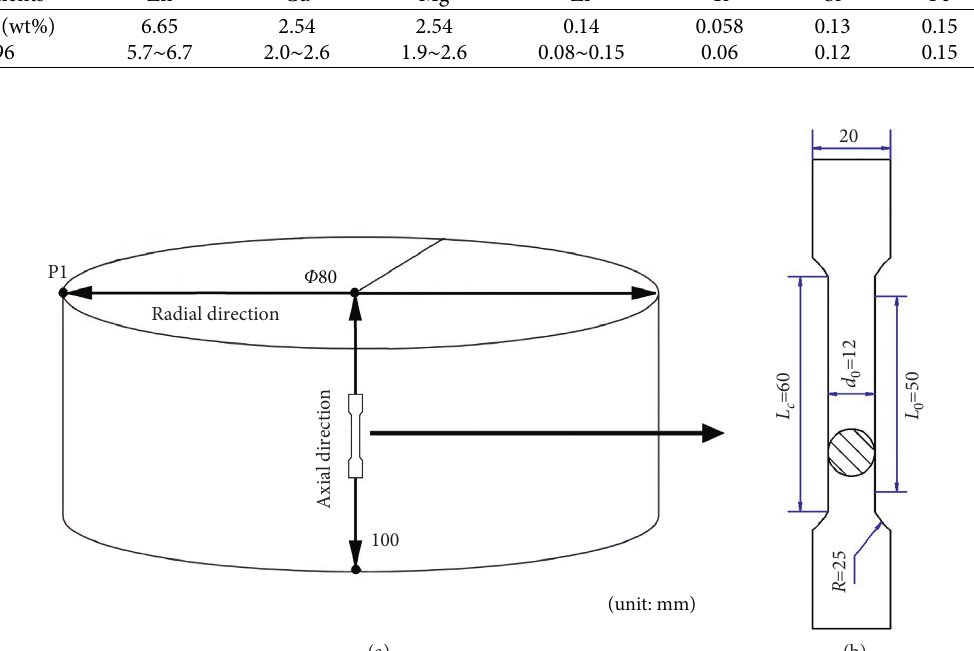
Figure 1: The sampling position (a) and the size diagram (b) of standard tensile specimen (mm).